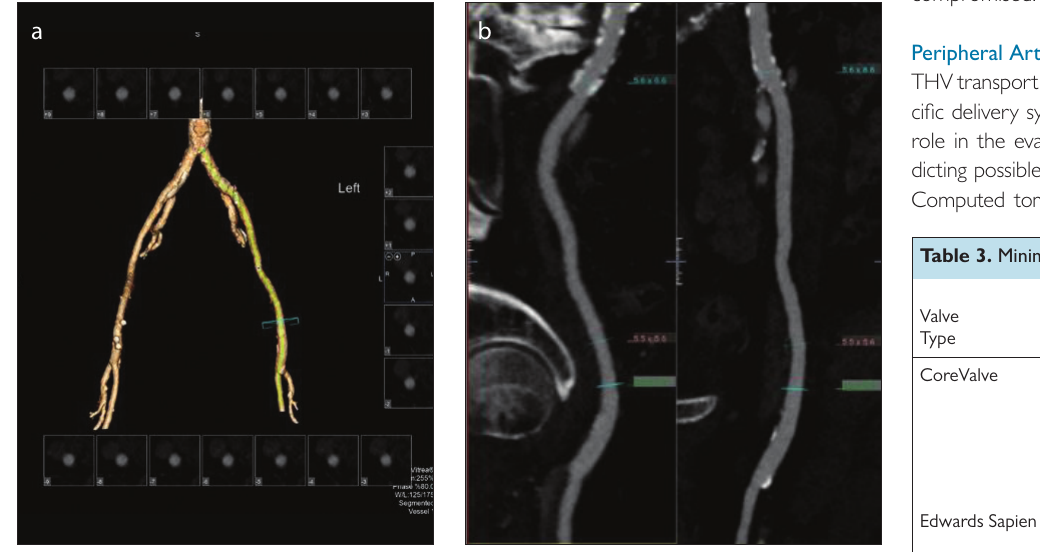
Figure 10. a, b. a) Three-dimensional volume-rendered image of the pelvic vasculature. b) Using the vessel probe function, we were able to show the curved multiplanar reformation of the left pelvic arteries in orthogonal views and to measure the maximum and minimum orthogonal diameters of the left common iliac, external iliac, and common femoral arteries.